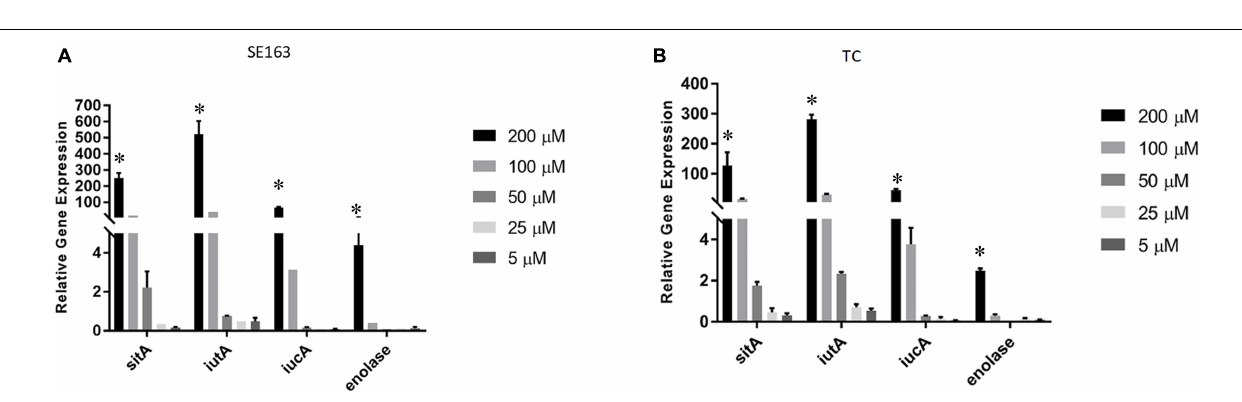
FIGURE 3 | Iron acquisition and other virulence gene expressions of S. enterica were increased in decreasing iron concentrations. Quantitative reverse transcription-PCR (qRT-PCR) was performed using SYBR green assays on the four genes sitA , iutA , iucA , and enolase to determine gene expression levels in LBID. The data presented in the graph are the transcription levels of four genes from either the wild-type SE163 (A) or the transconjugant (TC) (B) . Both strains were grown for 4 h in various LBID media using different concentrations of bipyridyl. Two biological replicates and three technical replicates were used for each sample ( ± SD). Gene expression was normalized by gmk and adk reference genes. Student’s t -test was performed between 5 µ M vs. 25 µ M; 5 µ M vs. 50 µ M; 5 µ M vs. 100 µ M; 5 µ M vs. 200 µ M with data being considered significant when p < 0.05. Asterisk ( ∗ ) indicates that increased expression of 4 genes at 200 µ M as compared to 5 µ M of bipyridyl was statistically significant for both SE163 and TC